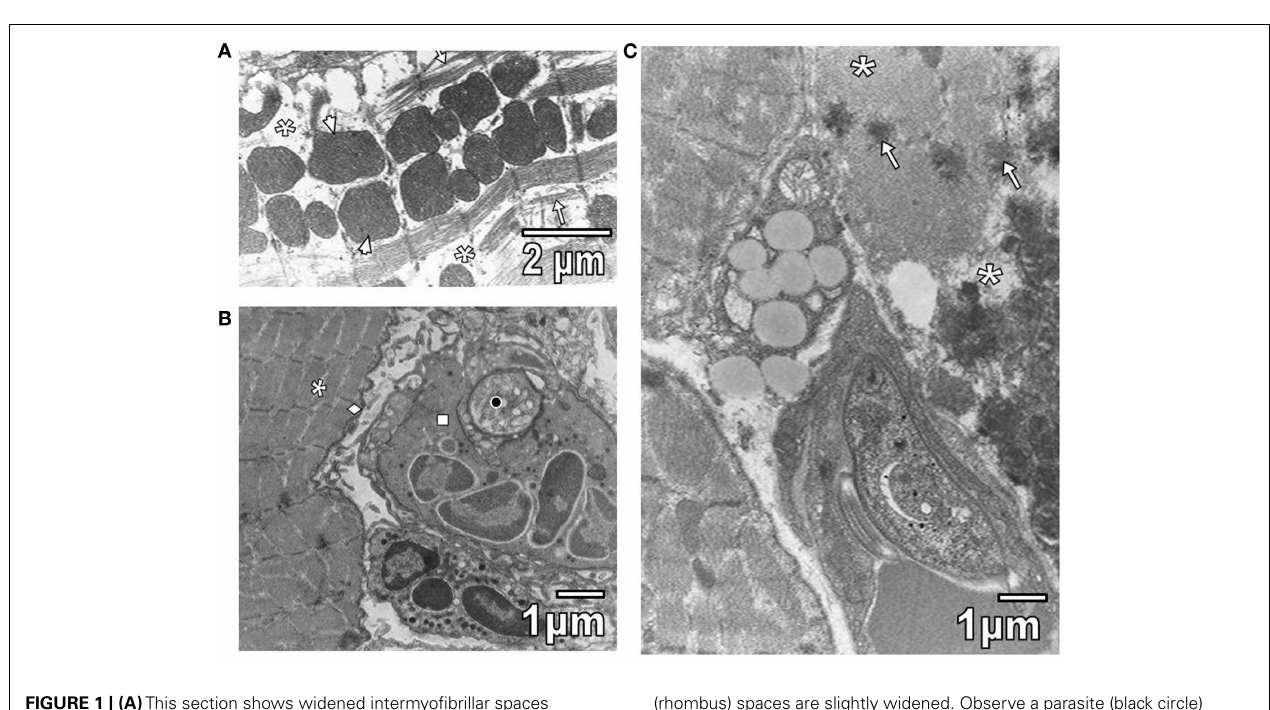
FIGURE 1 | (A) This section shows widened intermyofibrillar spaces (asterisks) of cardiac myocytes in T. evansi extensively occupied by mitochondria (arrowheads) and disorganized sarcomeres (star). (B) Section of skeletal muscle from a mouse parasitized with L. mexicana is shown . Intermyofibrillar (asterisk) and subsarcolemmal